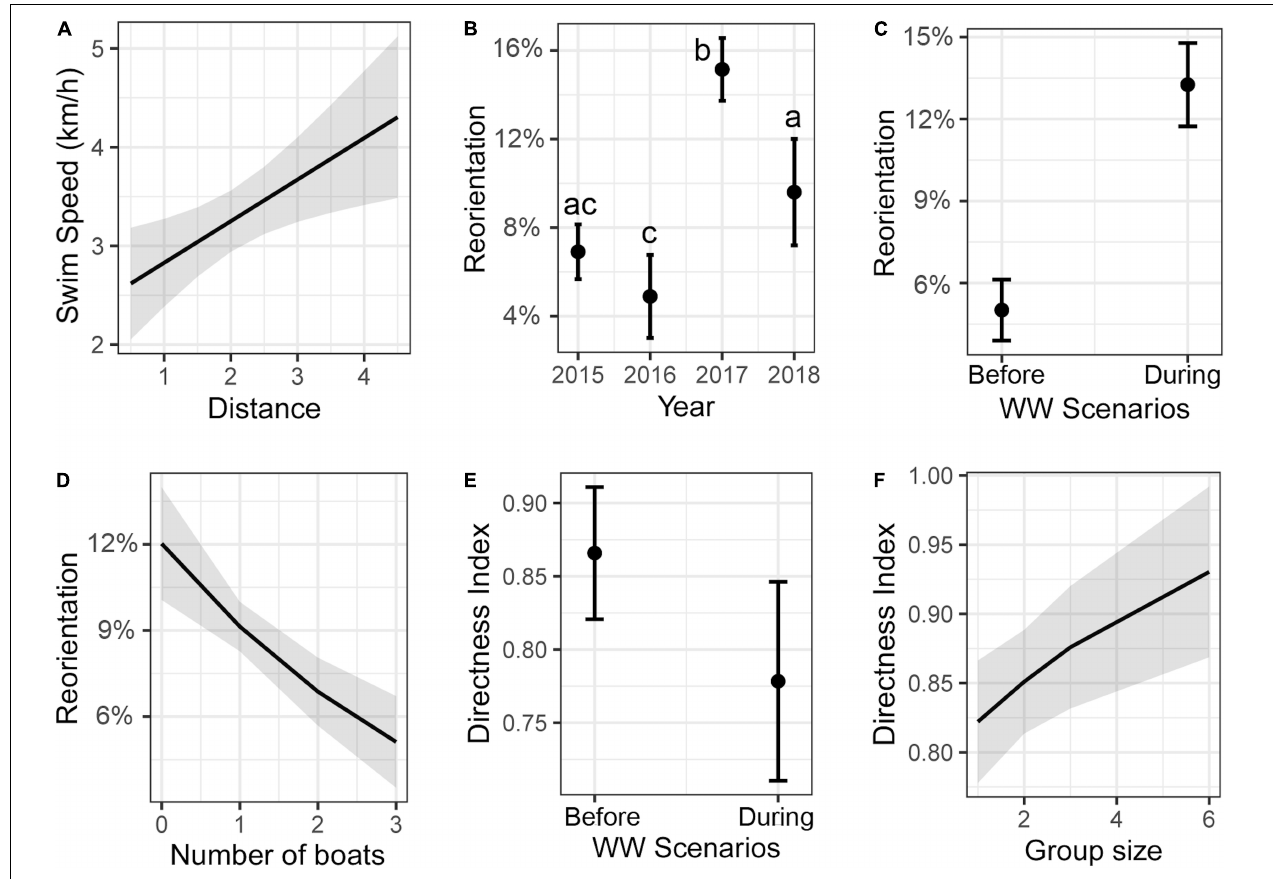
FIGURE 3 | Marginal effects (mean ± 95% confidence interval) from predictors of the best model for (A) swim speed, (B–D) reorientation, and (E,F) directness index during resting behavior of fin whales. Different letters indicate significant differences between groups (Tukey post hoc ; P <